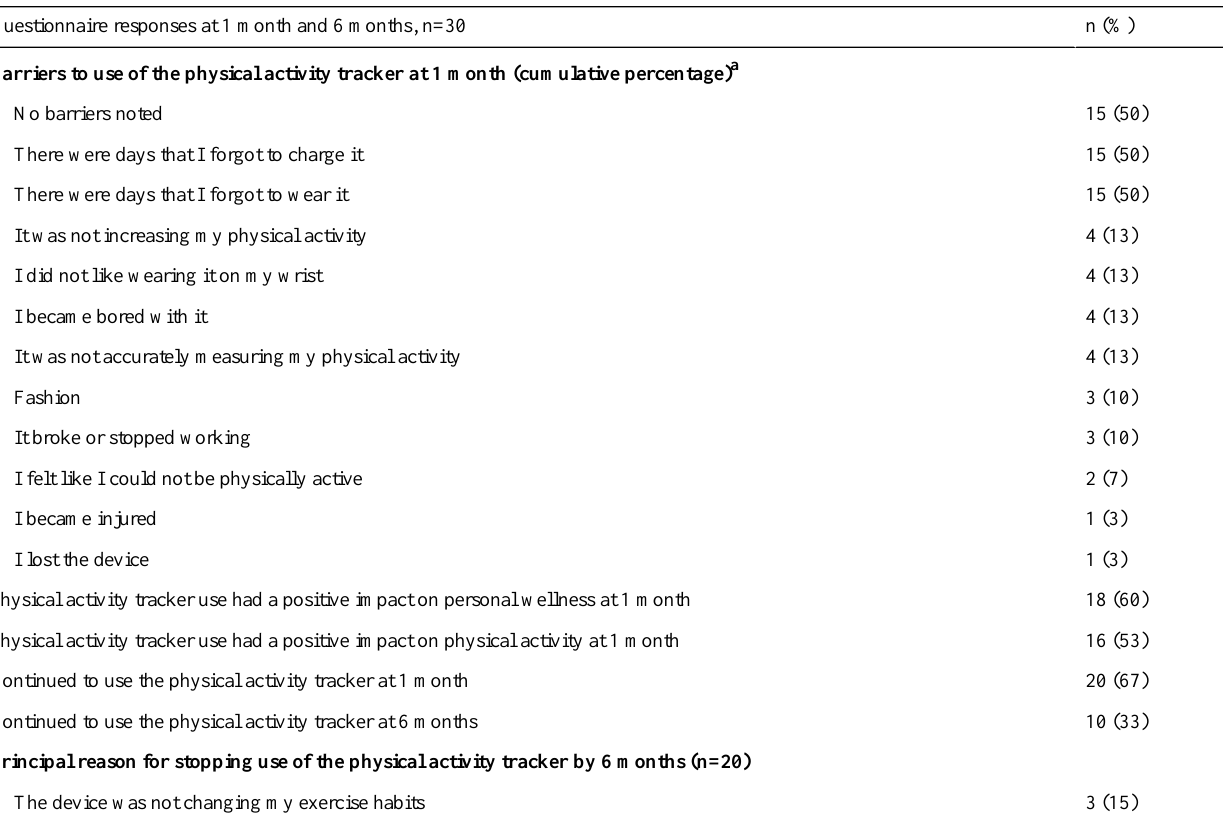
Table 3. Follow-up questionnaires on the use and barriers to use of the wearable device for tracking physical activity at 1 month and 6 months. Barriers to use of the physical activity tracker at 1 month (cumulative percentage) a